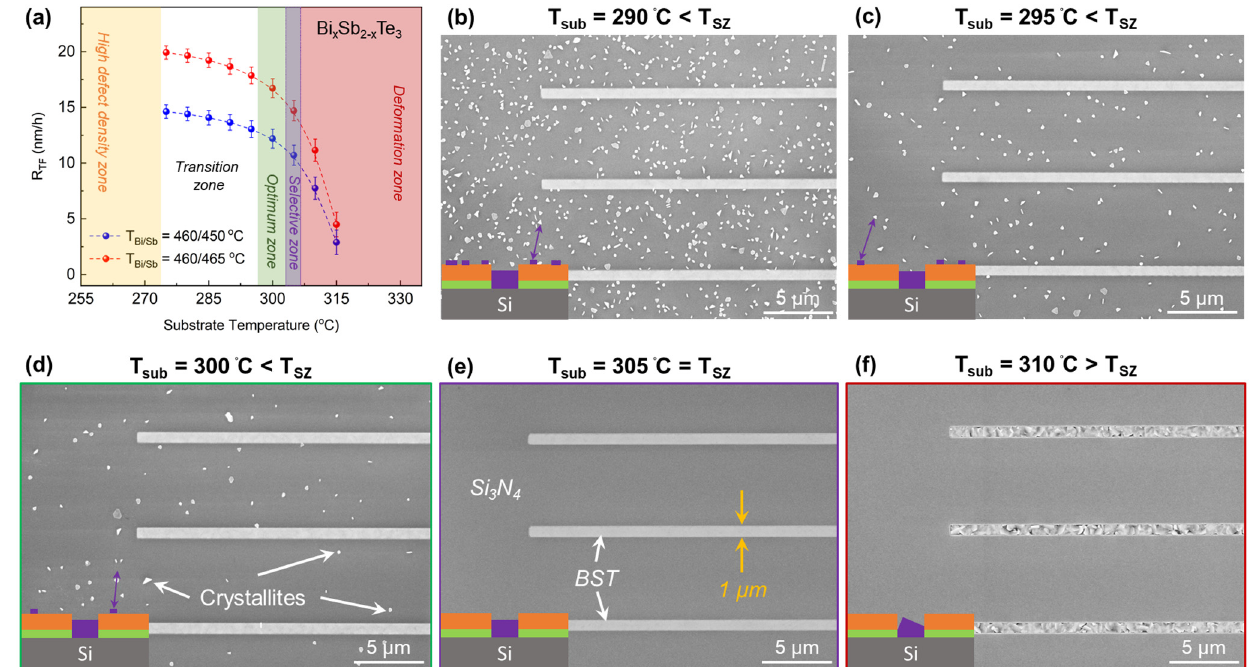
Figure 2. The effects of growth temperature ( T sub ) on planar and selectively grown TI films. ( a ) Tem ‐ perature ‐ dependent growth of BST planar films, where the sets of red and blue data points represent growths conducted at relatively high and low R TF , respectively. Based on XRD, the entire T sub range is divided into high defect density (yellow), transition (white), optimum (green) and deformation (red) temperature zones. The optimum zone is found to provide the highest crystal quality. During SAE on templated substrates, a finite temperature range is identified that provides perfect selectiv ‐ ity, along with a high crystal quality. This T sub range is named “selective temperature zone (T SZ )” and is highlighted with the purple color. SAE of BST crystal conducted outside the selective zone at ( b ) T sub = 290 °C, ( c ) T sub = 295 °C and ( d ) T sub = 300 °C, indicating non ‐ perfect selectivity due to pres ‐